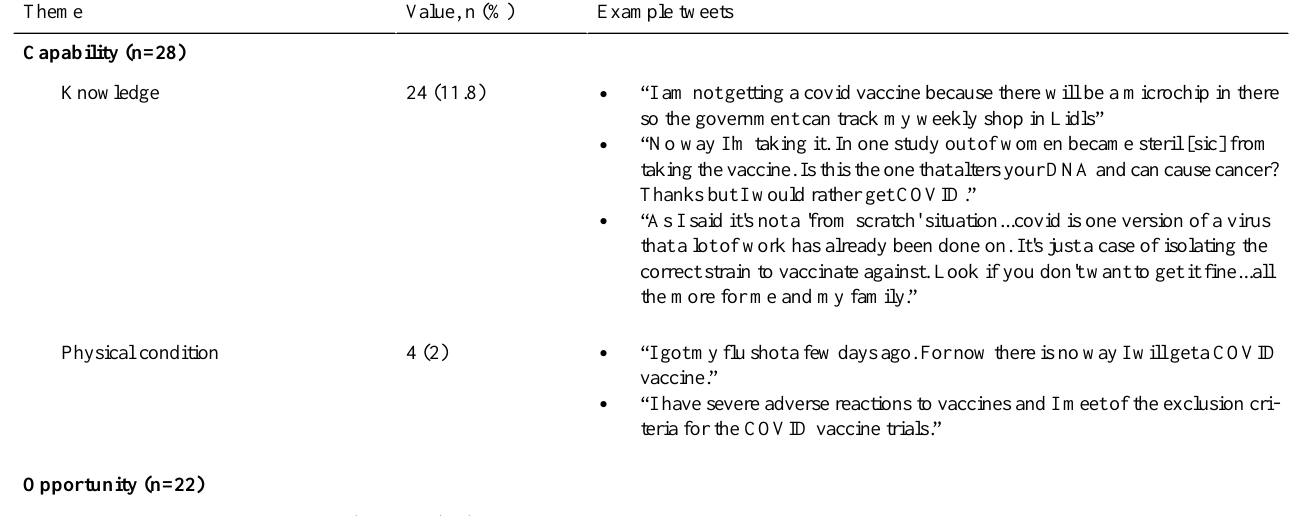
Table 2. Themes and example tweets (n=204).